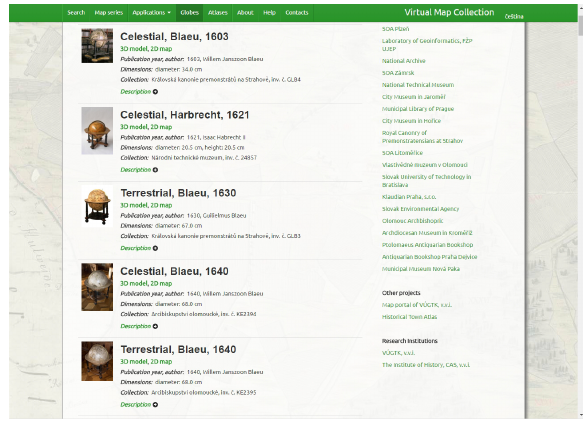
Figure 8. Globe section in Virtual Map